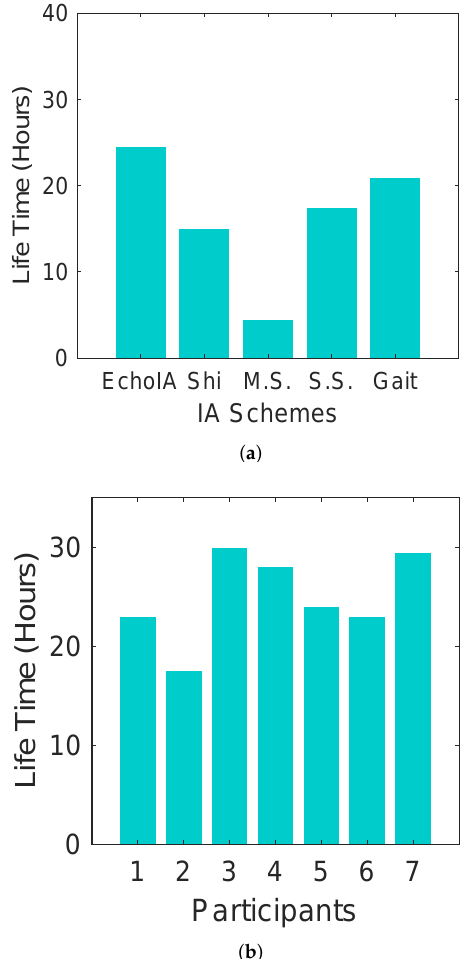
Figure 6. Battery Utilization. ( a ) Battery utilization of different schemes. M.S. denotes Multi-Sensor- IA. S.S. denotes SilentSense-IA. ( b ) Battery utilization of different